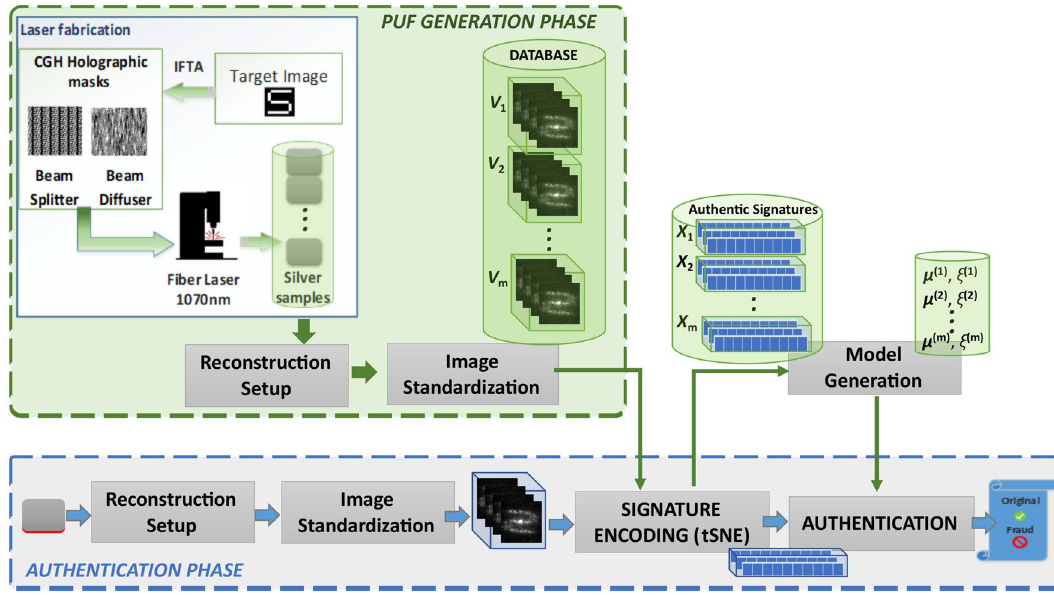
Figure 3. Schematic diagram of our methodology including laser fabrication, signature encoding and authentication